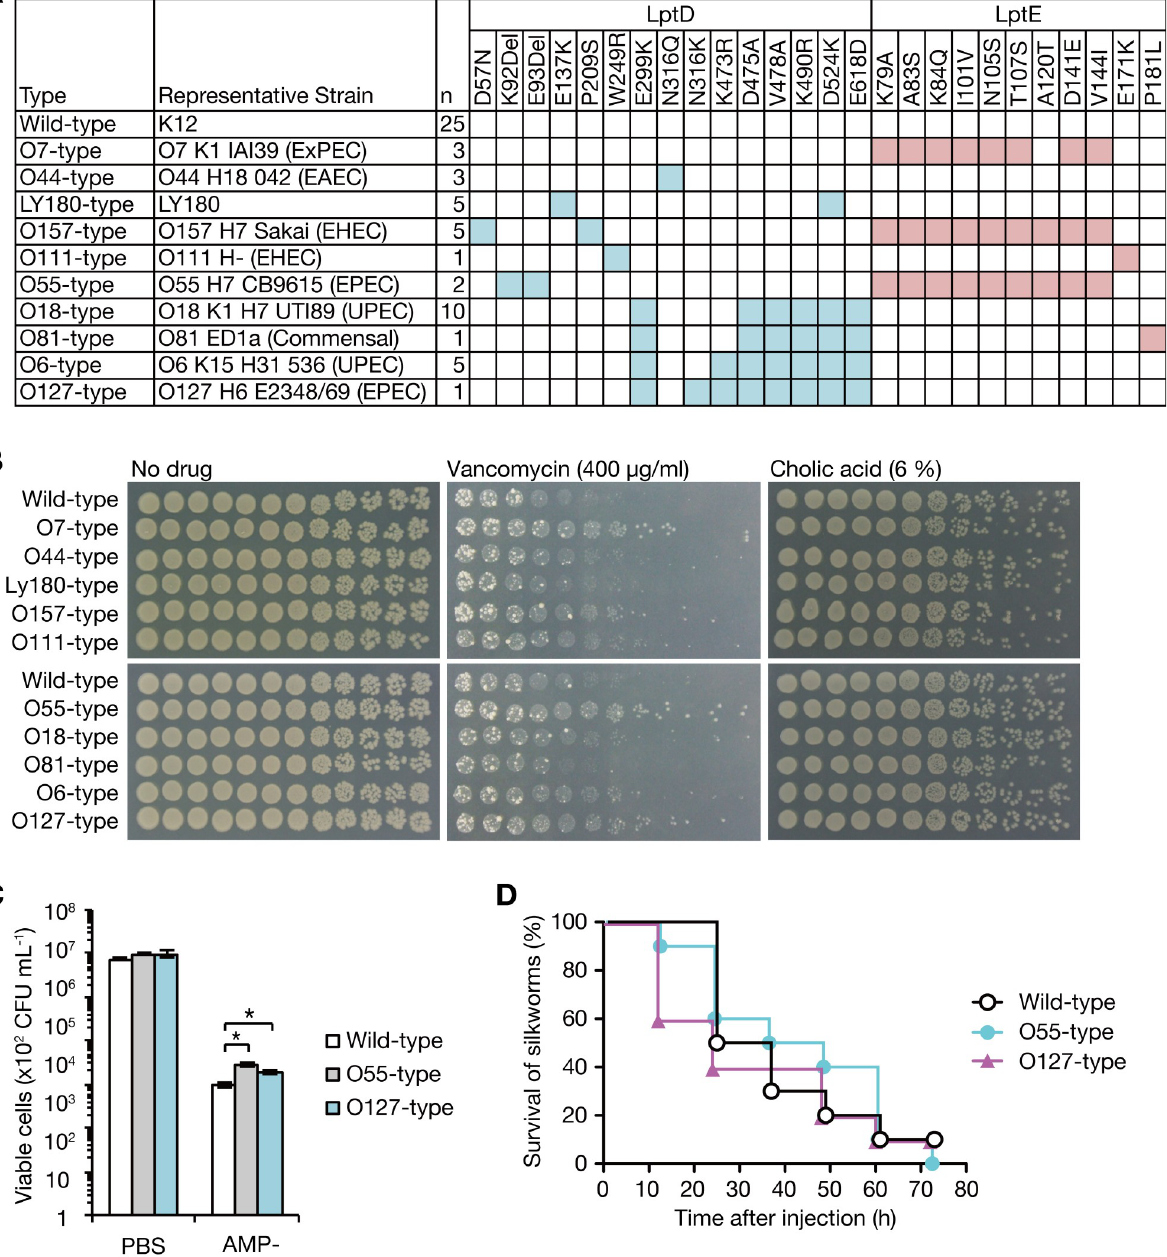
PLOS Pathogens| https://doi.org/10.1371/journal.ppat.1008469 April 23,